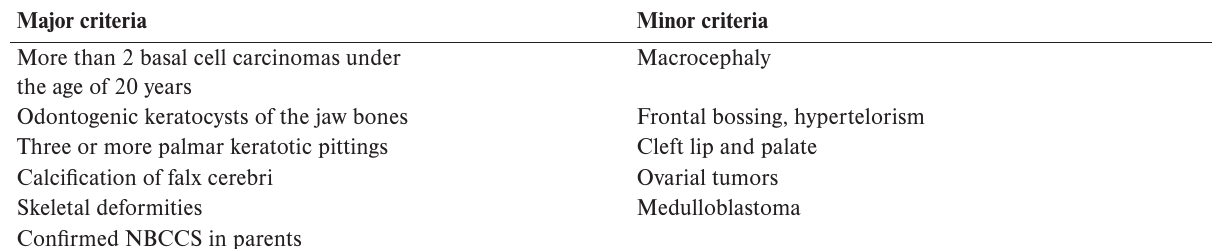
Table 1. Gorlin-Goltz syndrome – diagnostic criteria.